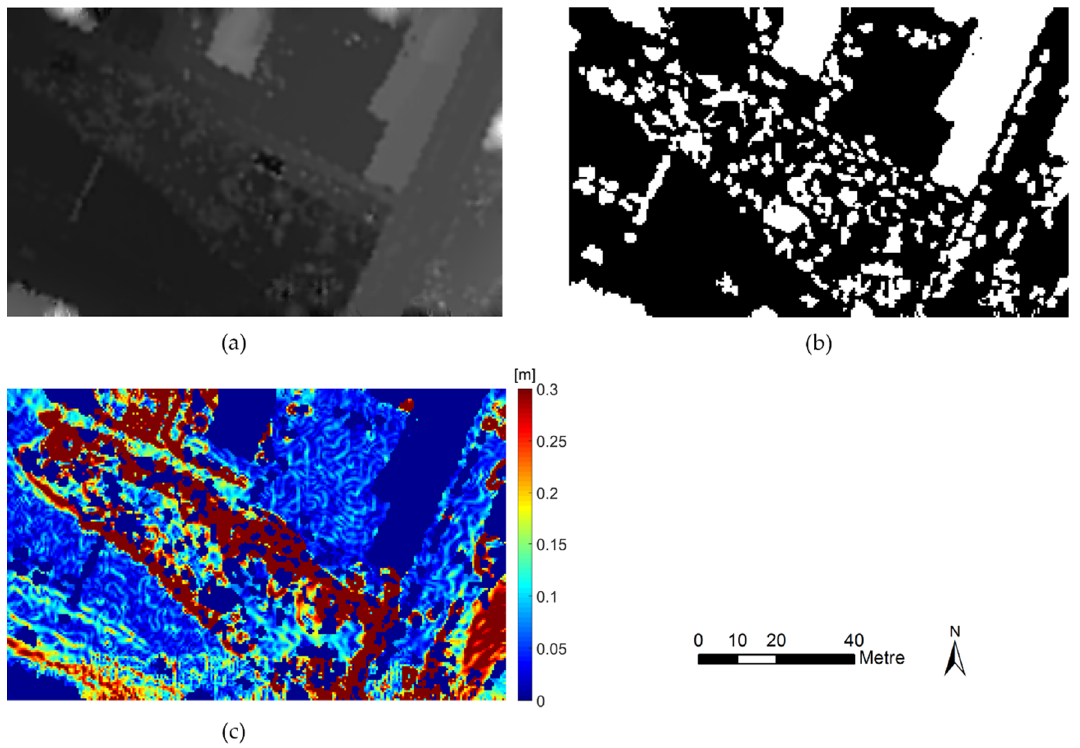
Figure 2. ( a ) Digital surface model (DSM); ( b ) the result of ground pixel extraction (black represents ground pixels), and the gradient compensation only performed at ground pixels; ( c ) the value of gradient compensation.